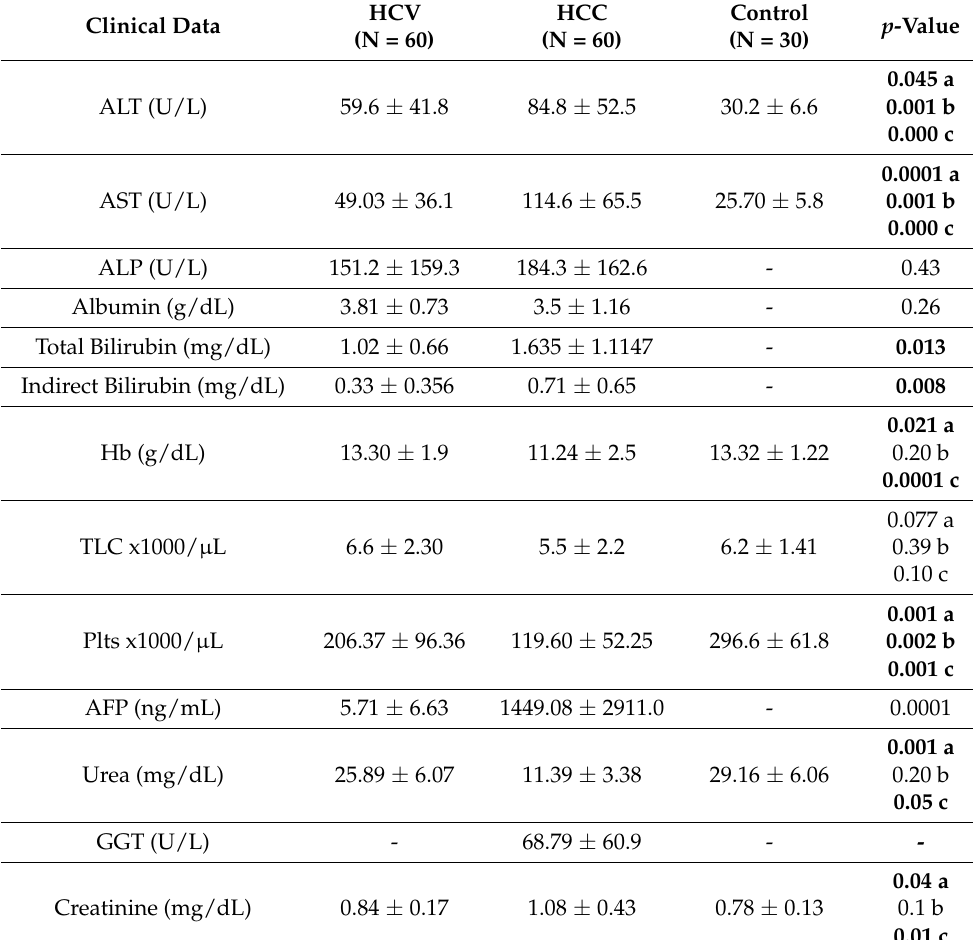
Table 2. Laboratory findings in the studied